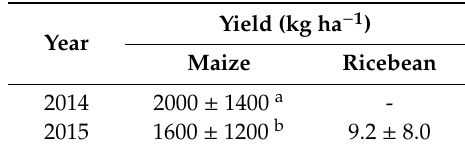
Table 6. Yields (mean ± standard error) of maize and ricebean before (2014) and after (2015) ricebean integration at the studied villages in Viengkham